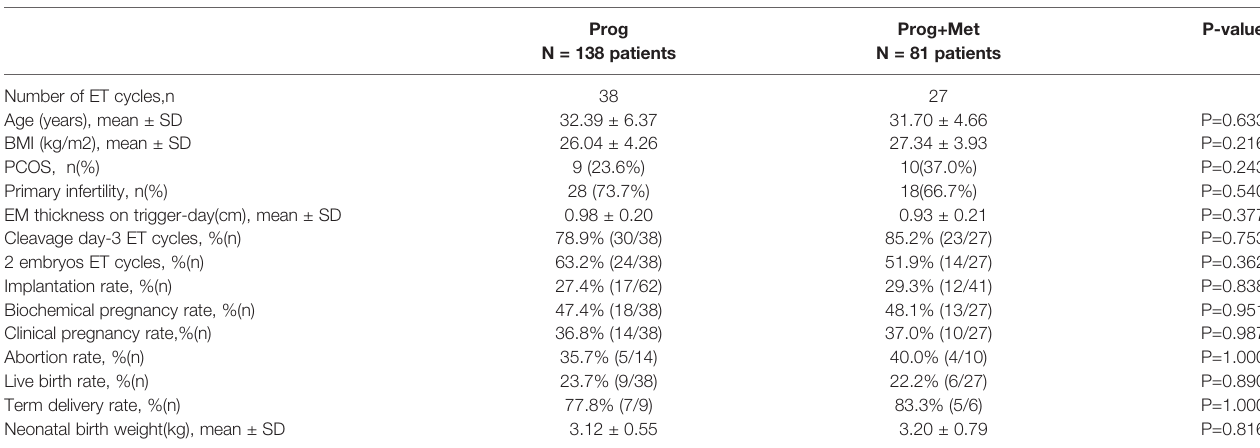
TABLE 6 | Baseline factors and reproductive outcomes calculated per fresh ET